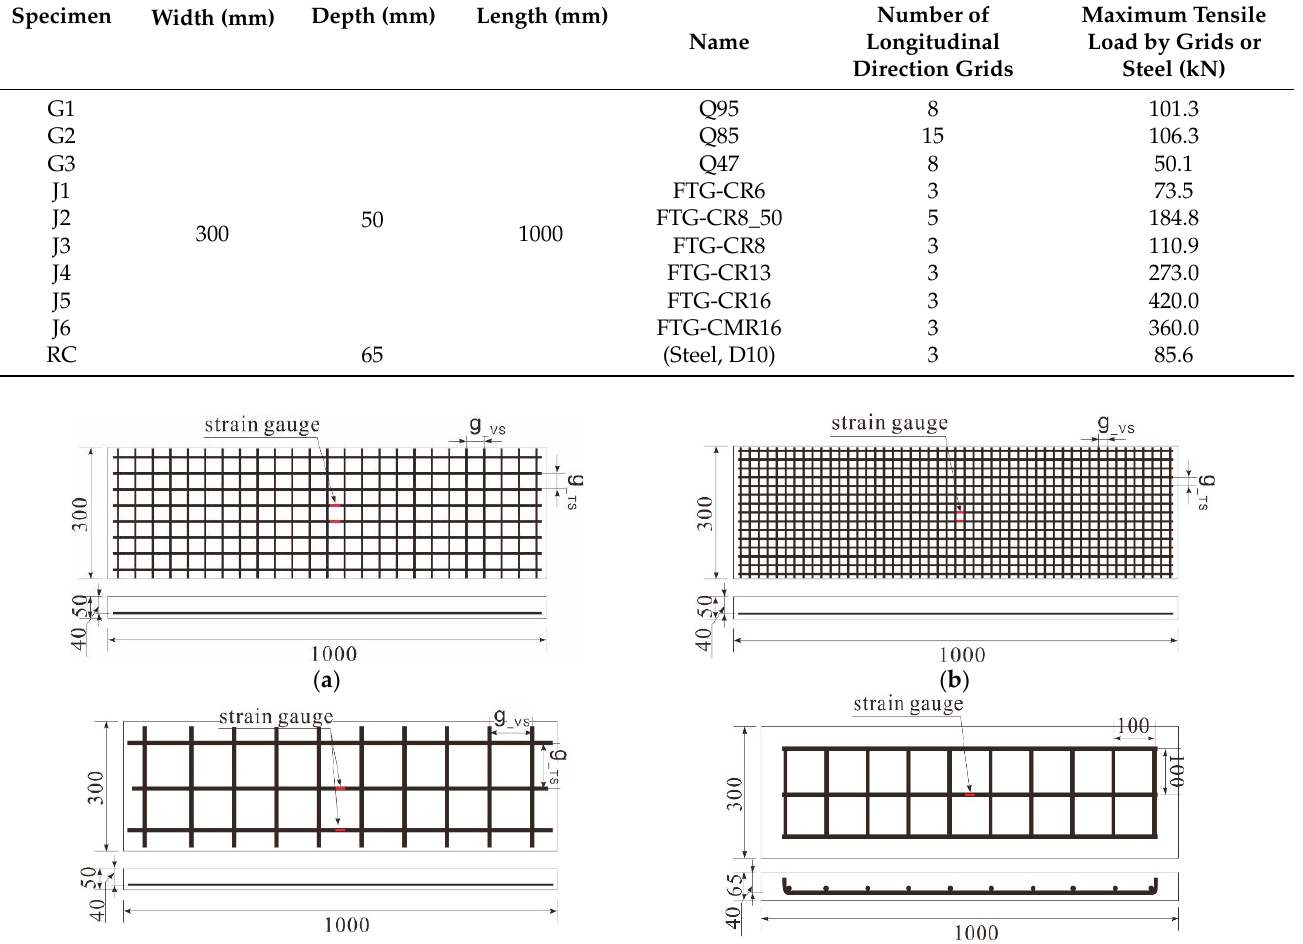
Figure 2. Specimens reinforced by: ( a ) Q95 and Q47; ( b ) Q85; ( c ) FTG-CR6, FTG-CR8_50, FTG-CR8, FTG-CR13, FTG-CR16, and FTG-CMR, and ( d ) steel.